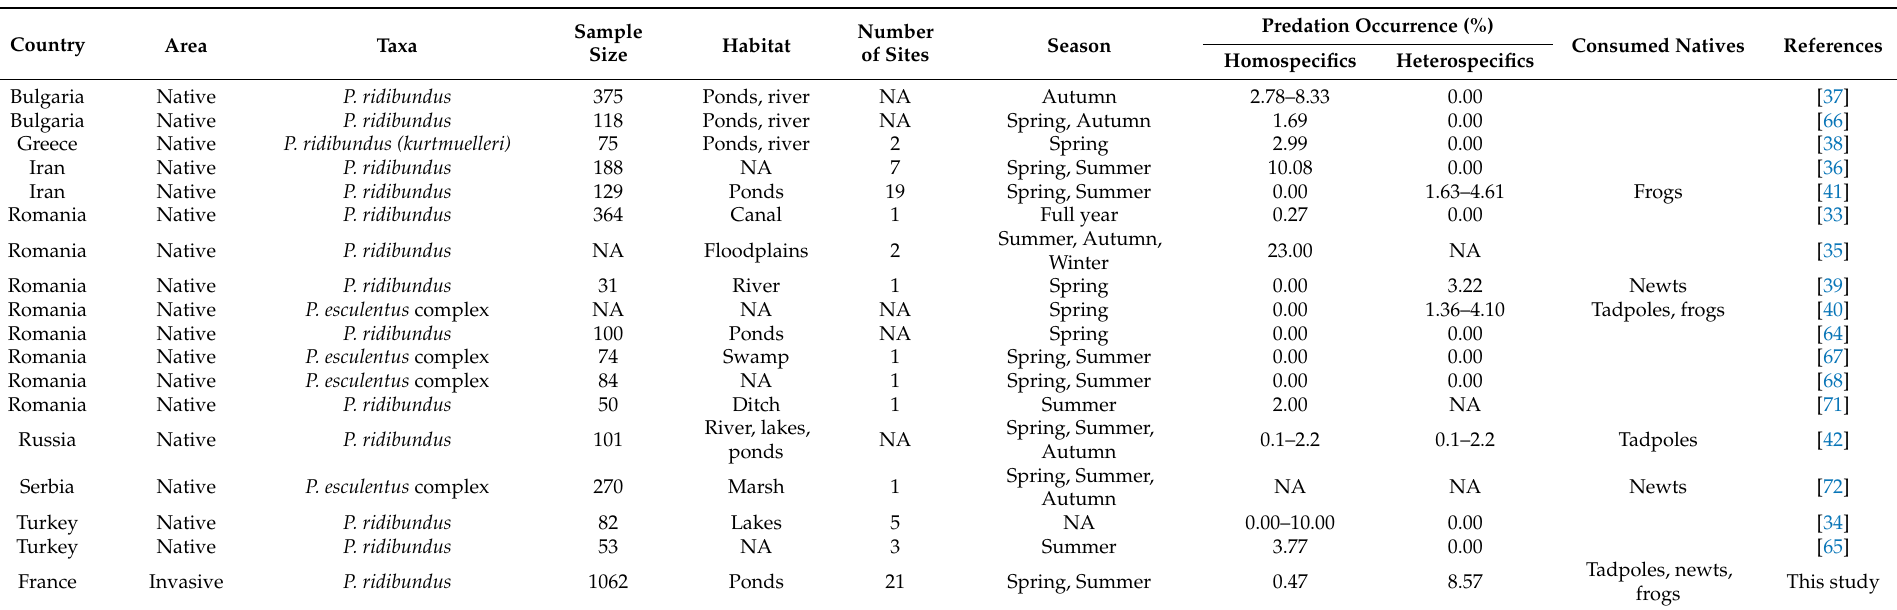
Table 2. Frequency of occurrence of amphibian consumption by marsh frogs according to previous diet studies and the present study (highlighted in bold). Studies that did not mention if consumed amphibians were linked to cannibalism or predation on heterospecifics were not included.